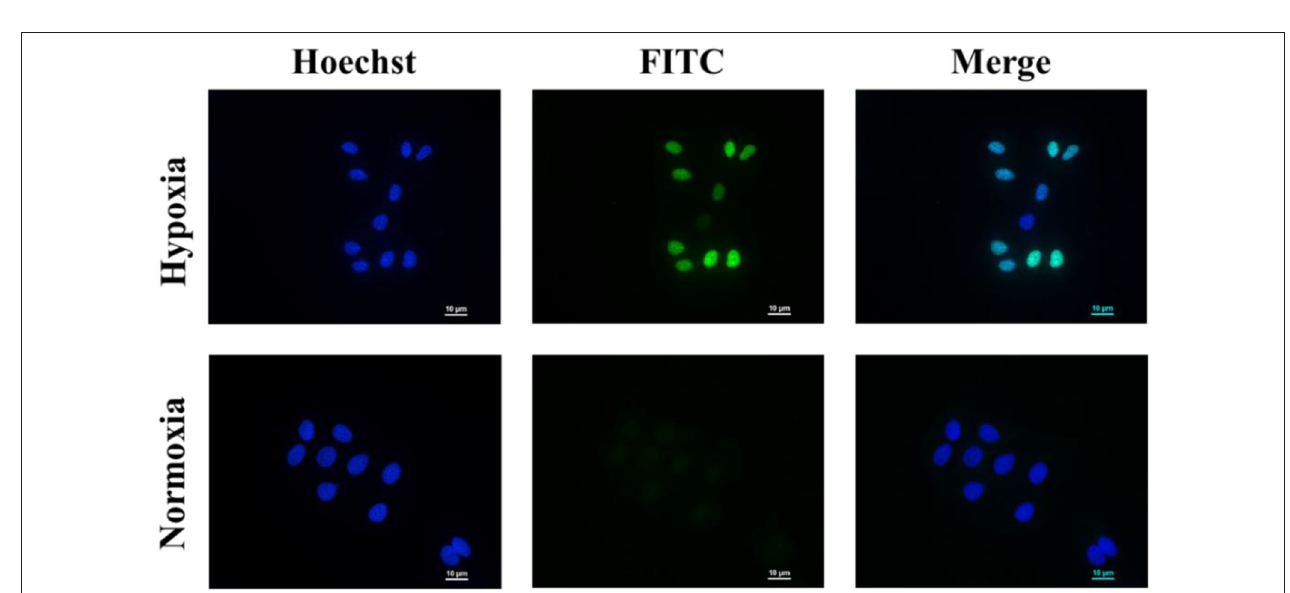
FIGURE 5 | Cell apoptosis of PEGN/DOX under normoxic and hypoxic conditions. Scale bars are all 10 µ